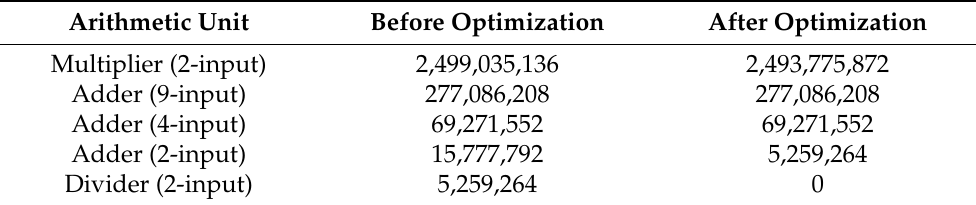
Table 3. Calculation after and before algorithm optimization.